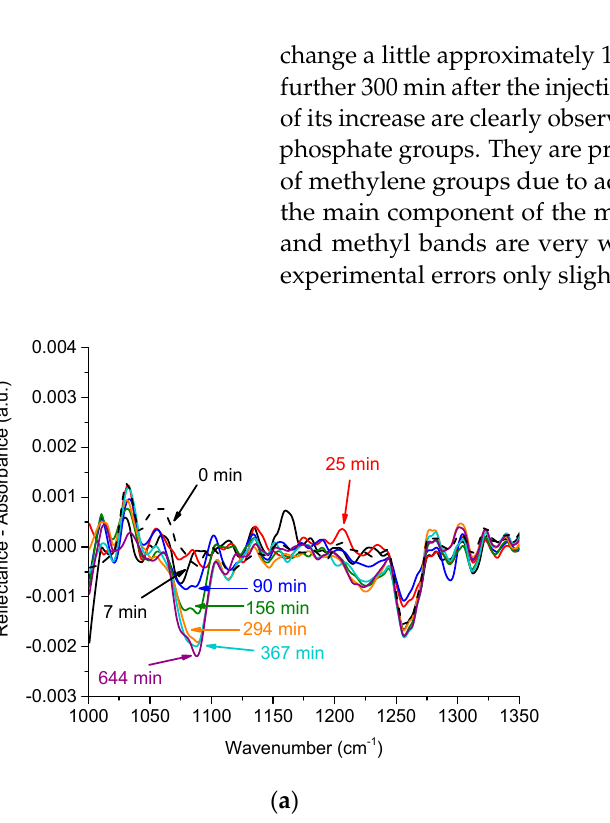
Figure 7. IRRAS spectra 1000–1350 cm − 1 ( a ) and 2500–3100 cm − 1 ( b ) of a PDAHMAC layer in different times after the DNA injection into subphase. The total DNA concentration is 56 μ M and the initial surface pressure of the PDAHMAC monolayer is 11 mN/m. Dashed black line corresponds to the PDAHMAC monolayer before the DNA injection.